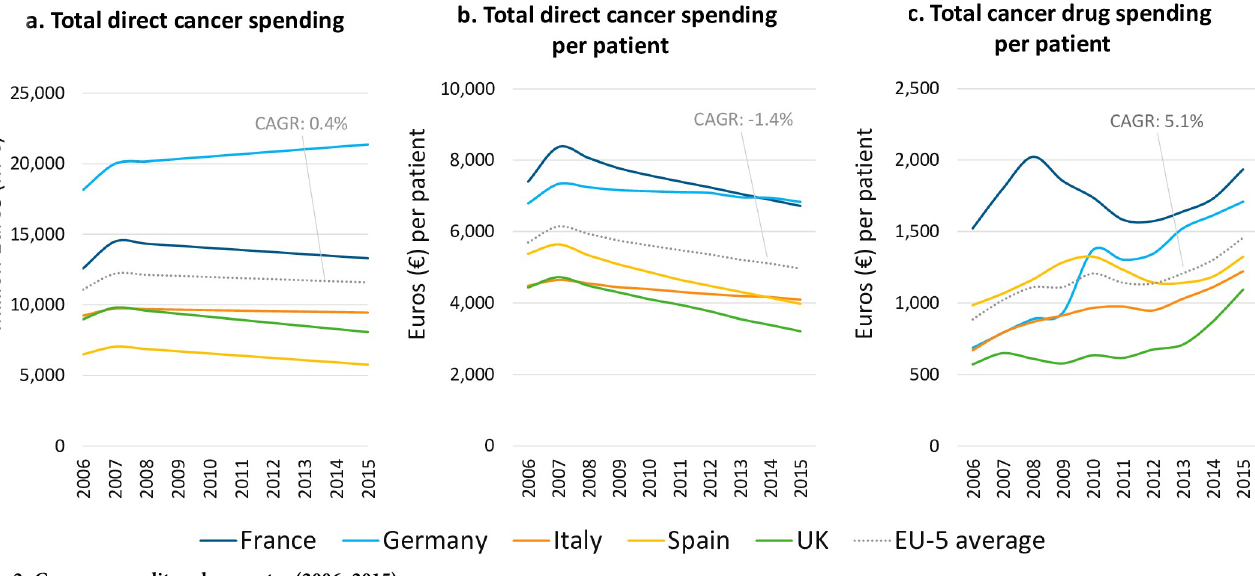
Fig 2. Cancer expenditure by country